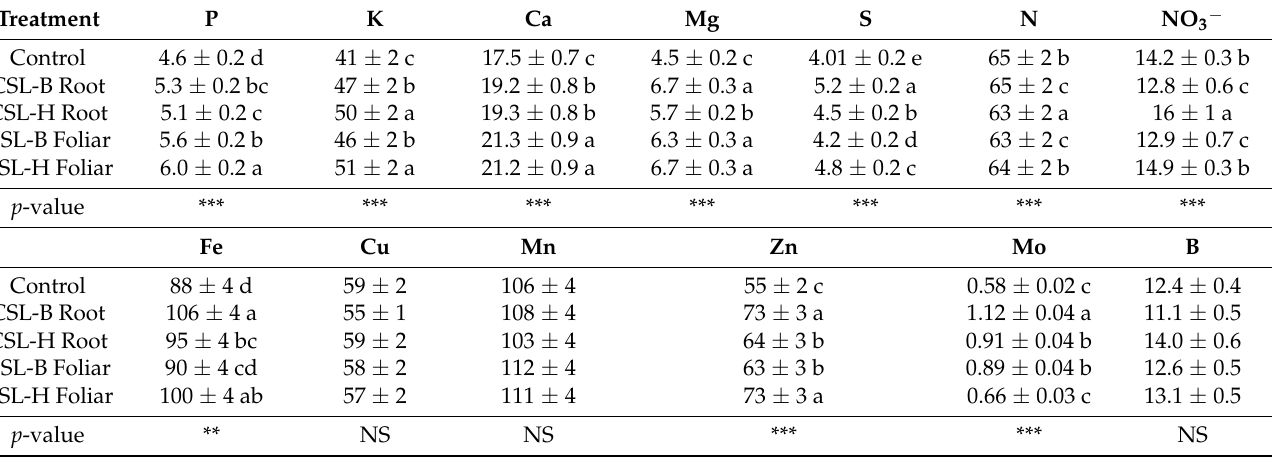
Table 7. Foliar concentrations of macronutrients (mg g − 1 DW) and micronutrients ( µ g g − 1 DW), for each of the treatments